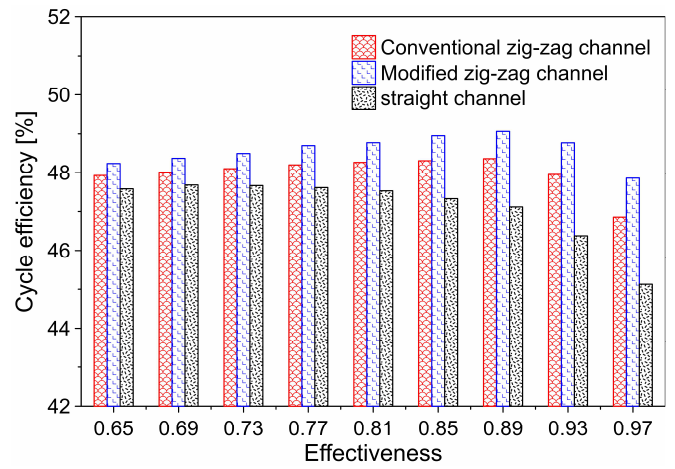
Figure 20. Efficiency of sCO 2 -BC cycle.